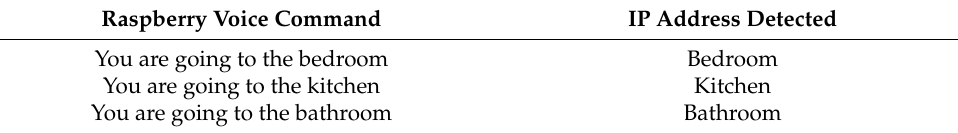
Table 1. Indoor destination information (feedback for the system).